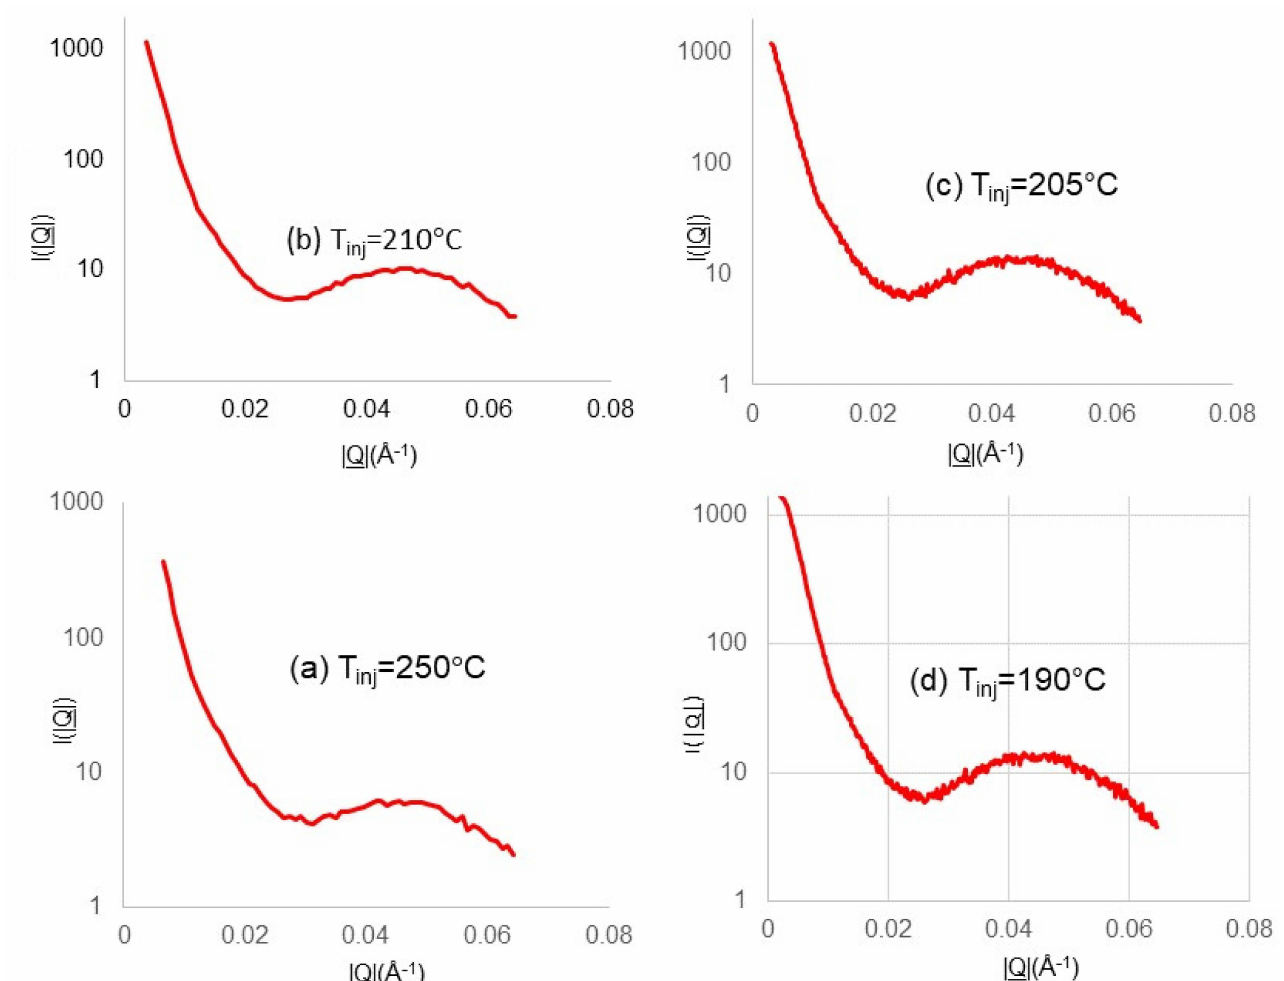
Figure 7. Plots of the section through the 2D SAXS pattern recorded 100 s after the first crystallization for each of the experiments shown in Figure 6. The section was taken in the horizontal direction passing through the centre of the pattern. The data were averaged over a small |Q| interval (5 × 10 − 3 Å − 1 ) in the vertical axis at each |Q| value in the horizontal direction. The vertical scale is logarithmic. The temperature of injection is shown on each